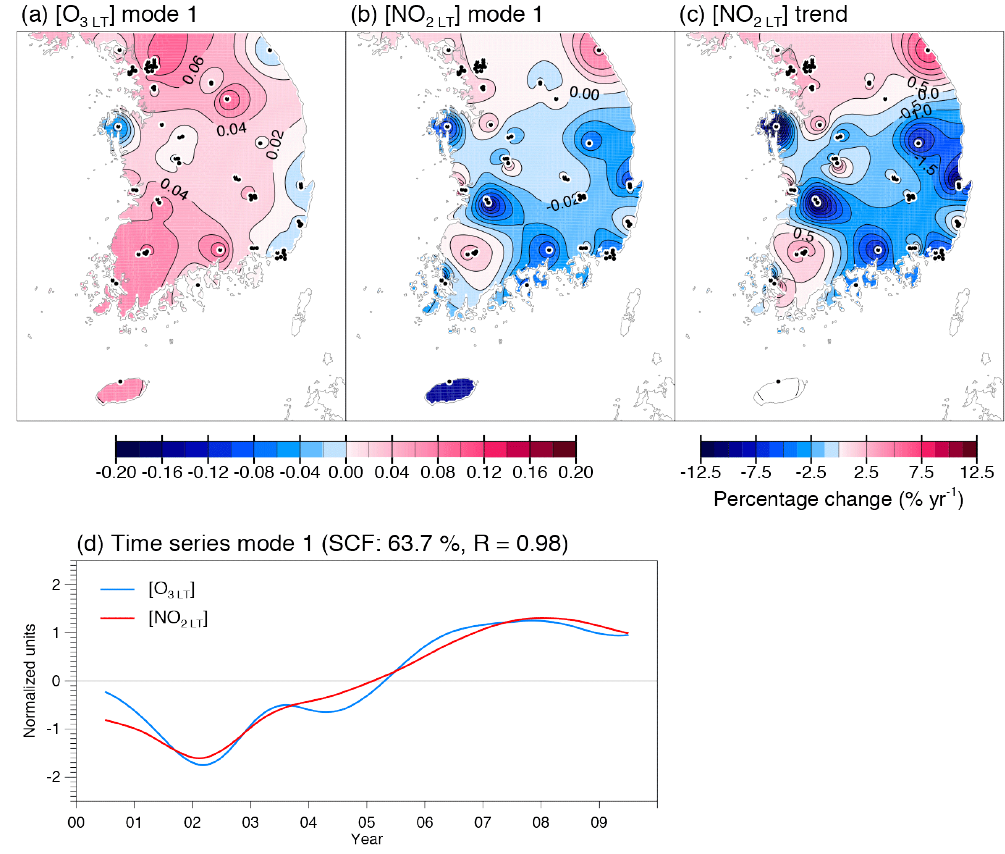
Figure 14. The first leading mode of SVD between the long-term components of (a) daily maximum 8h average O 3 ([O 3LT ]) and (b) daily average NO 2 [NO 2LT ] for the period 2000–2009. (c) Spatial distribution of temporal linear trends of [NO 2LT ]. (d) Time series of the SVD expansion coefficient associated with [O 3LT ] mode (blue line) and [NO 2LT ] mode (red